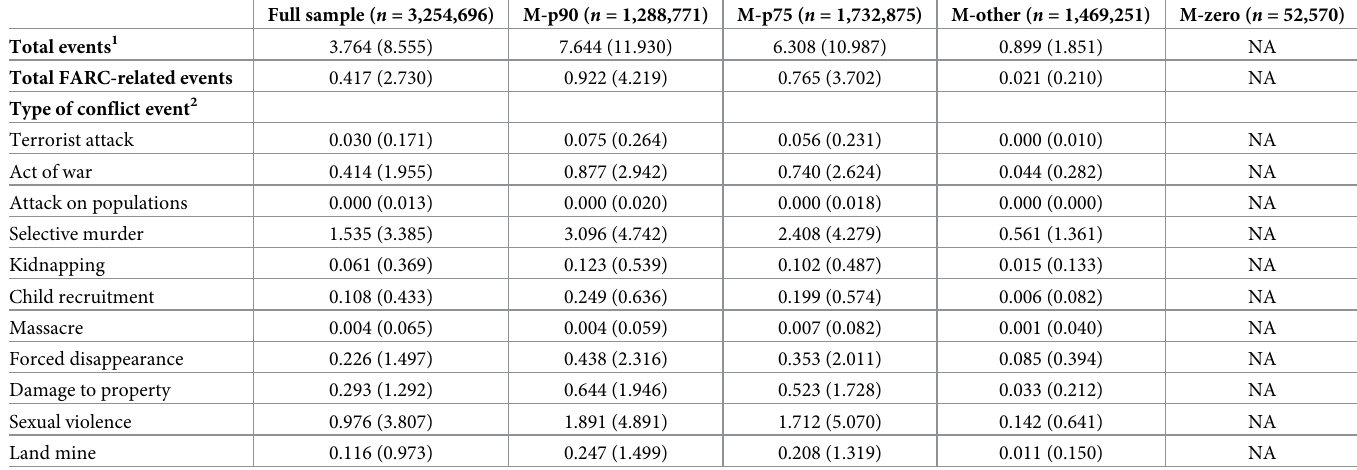
Table 2. Exposure to conflict violence events during